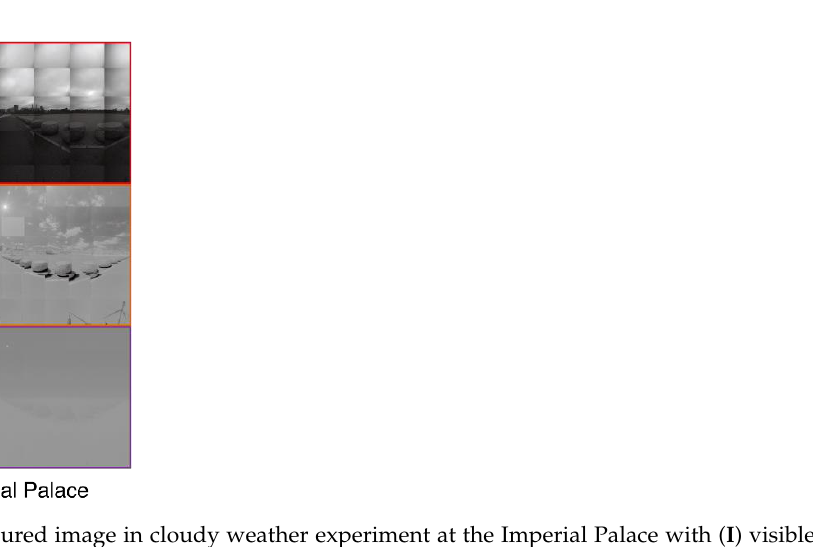
Figure 13. Measured image in cloudy weather experiment at the Imperial Palace with ( I ) visible, ( II ) near-infrared, and ( III ) far-infrared light camera.